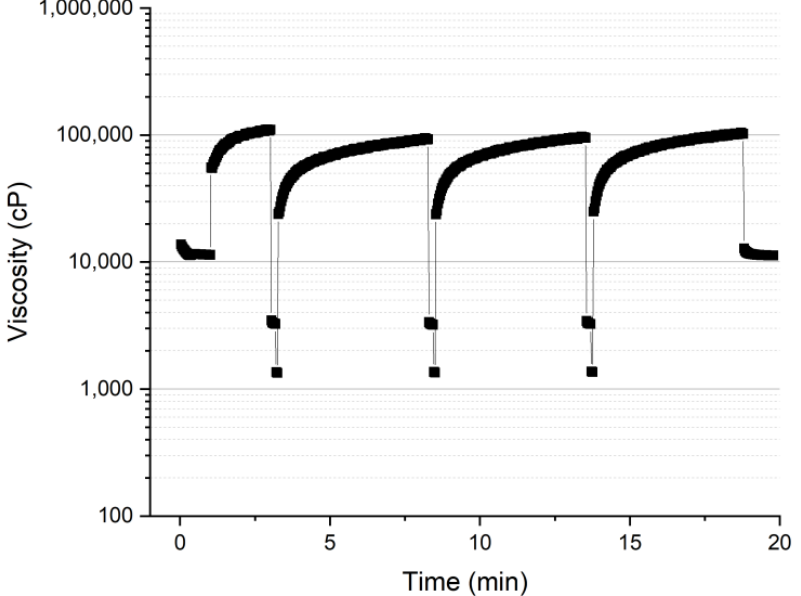
Figure 2. Time-dependent viscosity (thixotropic property) of the modified Nafion ink measured by three-level flow method.